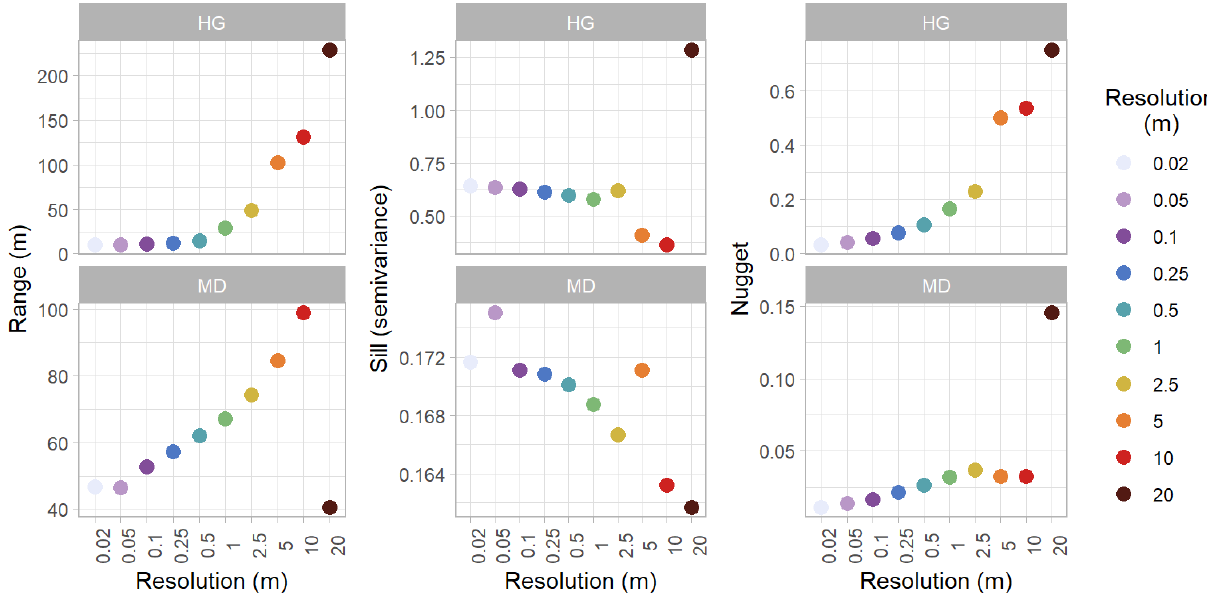
Figure 7. Seasonally averaged range, sill, and nugget values for each resolution from spherical-fit models in the Hourglass (HG) and meadow (MD) using the nearest-neighbor resampling method. Colors represent different snow depth digital surface model (DSM) resolutions.